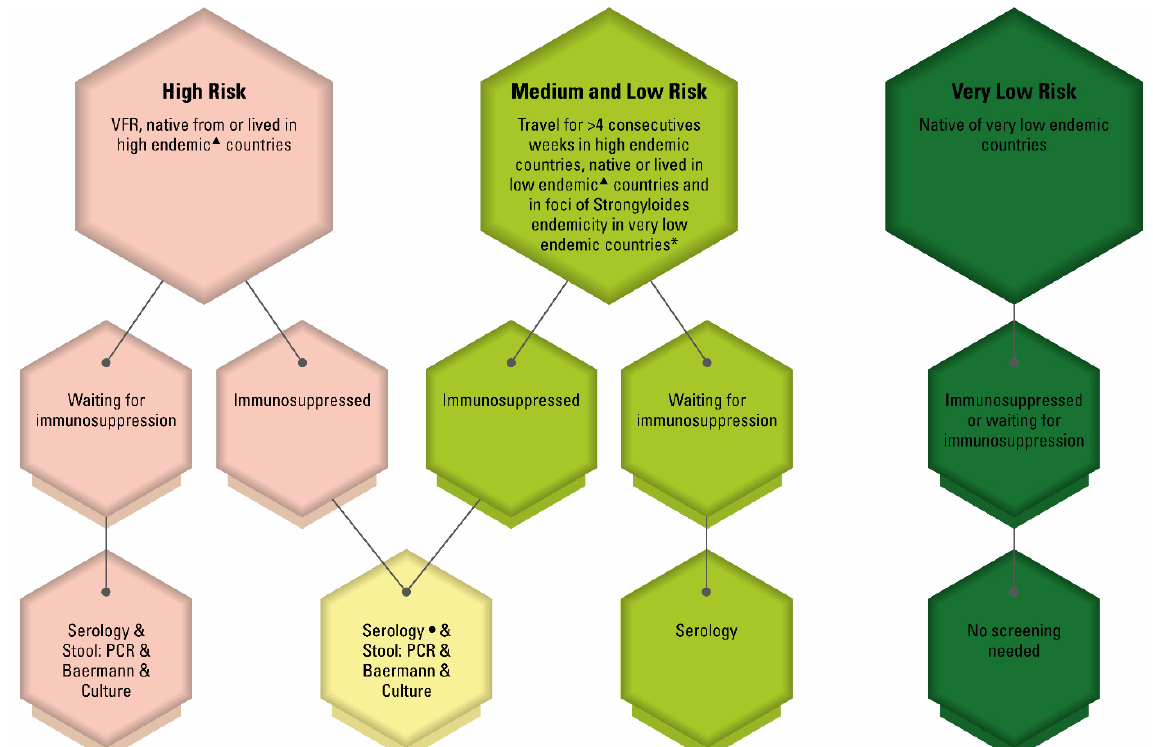
Figure 1. Screening algorithm for latent strongyloidiasis. Treat with ivermectin (200 μ g/kg) if serology and/or stool test is positive; if PCR is not available, repeat Baermann and culture for a total of three samples; if screening tests are not available, give empiric treatment with ivermectin (200 µ g/kg). VFR—visiting friends and relatives. Strongyloidiasis prevalence: high-endemic countries > 5%, low-endemic countries > 0.1% and ≤ 5%, very low-endemic countries ≤ 0.1% (modified from Buonfrate et al., The Global Prevalence of Strongyloides stercoralis Infection, Pathogens 2020). * Italy, southern Spain, Australian Aboriginal communities, southern USA and Japan. Consider a lower cutoff in the case of immunosuppression.